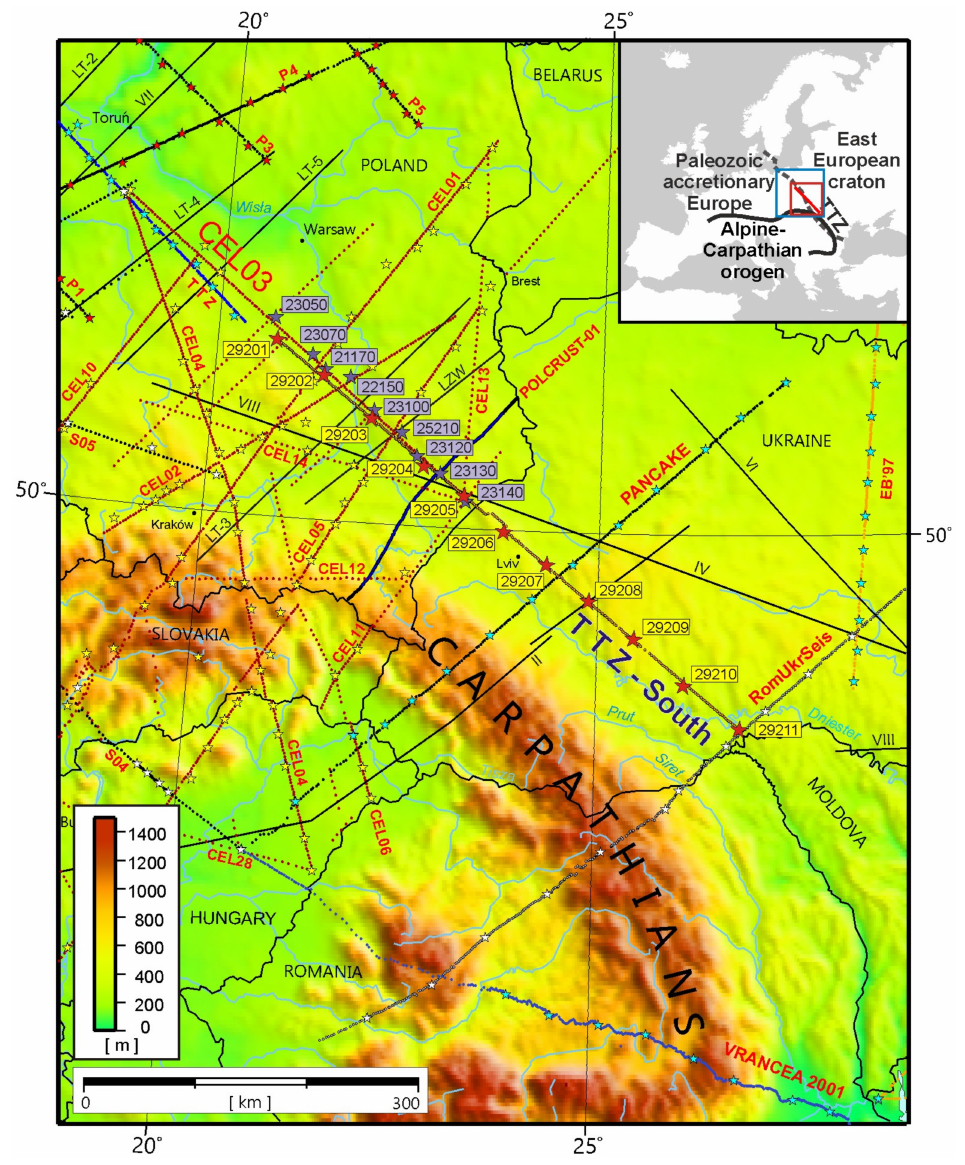
Figure 1. Location of the TTZ-South, CEL03 and other deep seismic sounding (DSS) profiles on a map of East-Central Europe (red box in the inset map, whereas the blue box shows the area hosting the whole, long TTZ-CEL03-TTZ-South transect). Stars and numbers refer to locations of shot points along the transect TTZ-CEL03-TTZ-South. The beginning of this long transect corresponds to